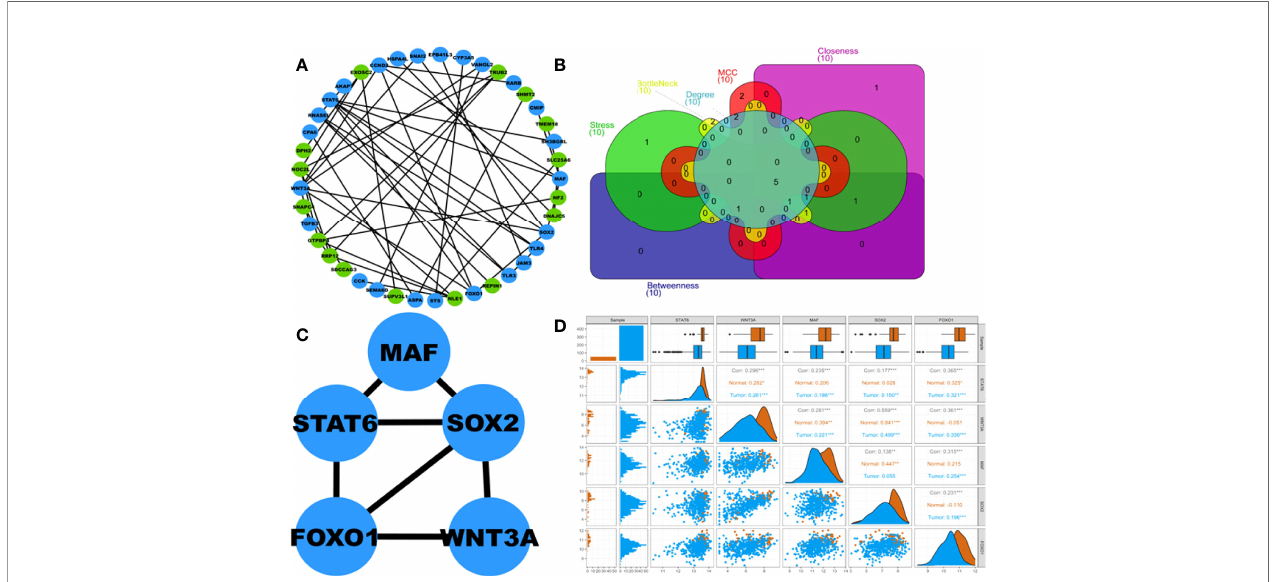
FIGURE 4 | (A) Protein-protein interaction (PPI) network comprising 41 nodes and 48 edges corresponding to STRING interaction score>0.4. Blue and green nodes represent up and downregulated proteins, respectively. (B) Venn plot showing 5 overlapping hub DEGs within 6 centrality-based ranked genesets. The Venn plot ’ s green, red, cyan, magenta, yellow, and violet areas represent stress, MCC, degree, betweenness, bottleneck, and closeness centrality-based ranked genesets. (C) Highest-scoring PPI hub cluster comprises 5 nodes and 7 edges. (D) Pairwise scatter plot showing the associations amongst these 5 hubs upregulated DEGs. The upper triangular section represents the Spearman correlation coef fi cients between these DEGs and expression boxplots for each DEG. The lower triangular section represents the scatterplot and histogram distribution between these DEGs. The diagonal consists of kernel densities for each DEG. Signi fi cant levels at 0.05, 0.01, and 0.001 are represented by *, **, and ***,